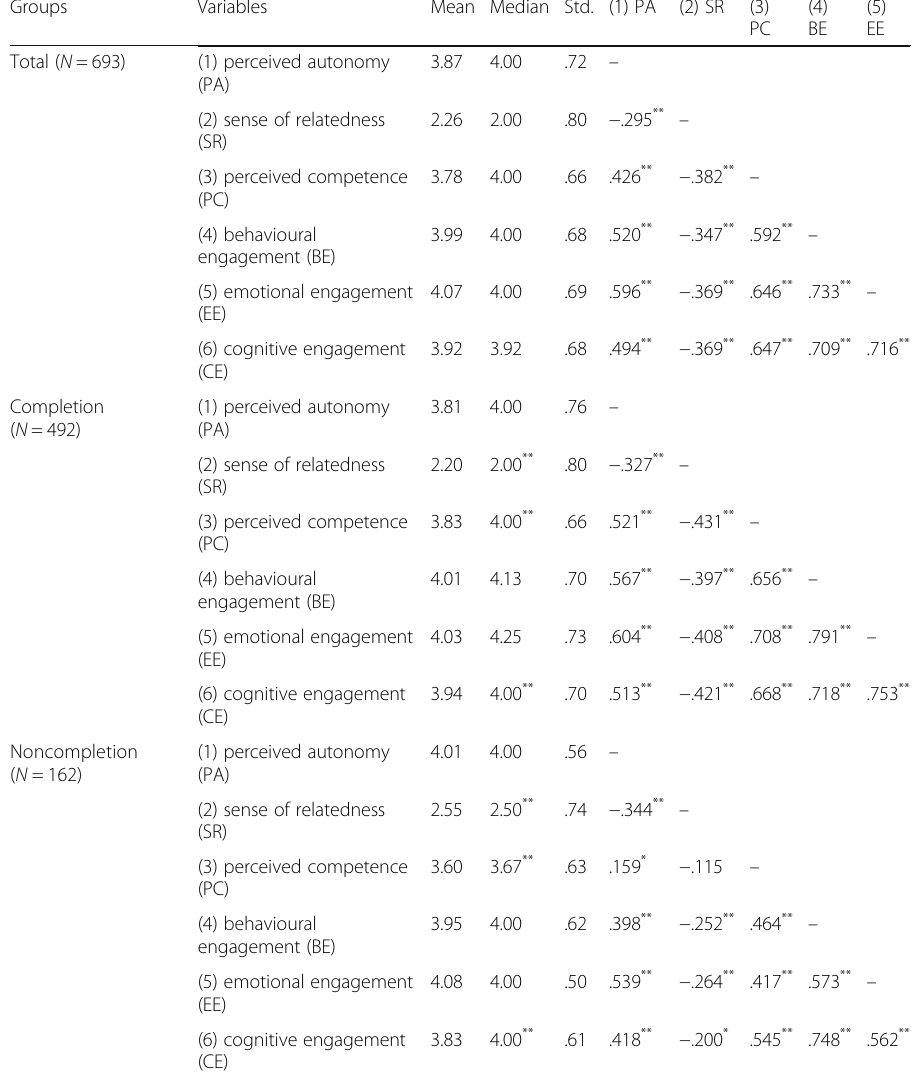
Table 4 Relationships between components of SDT and components of engagement